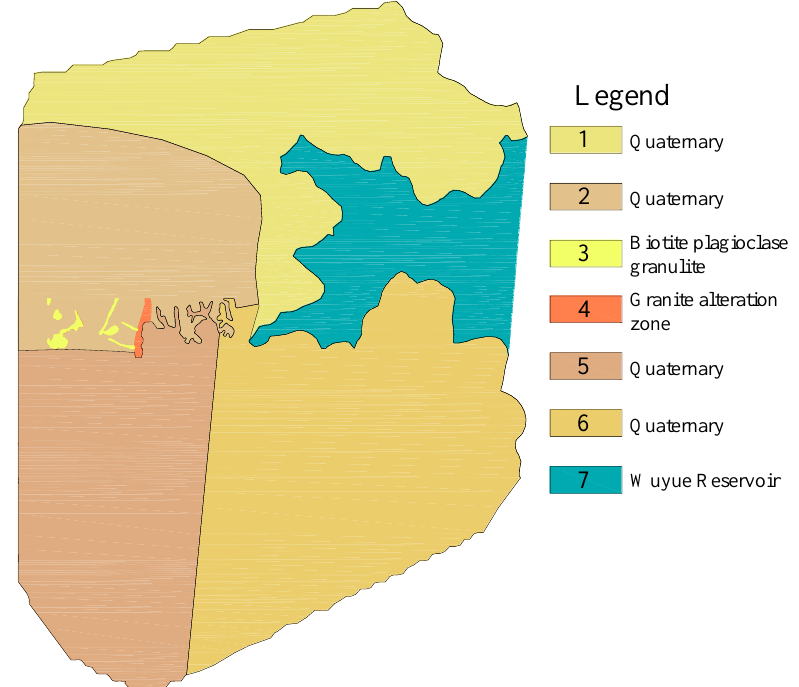
Figure 7. Hydrogeological model subdivision. Table 2. Permeability coefficient of each layer.